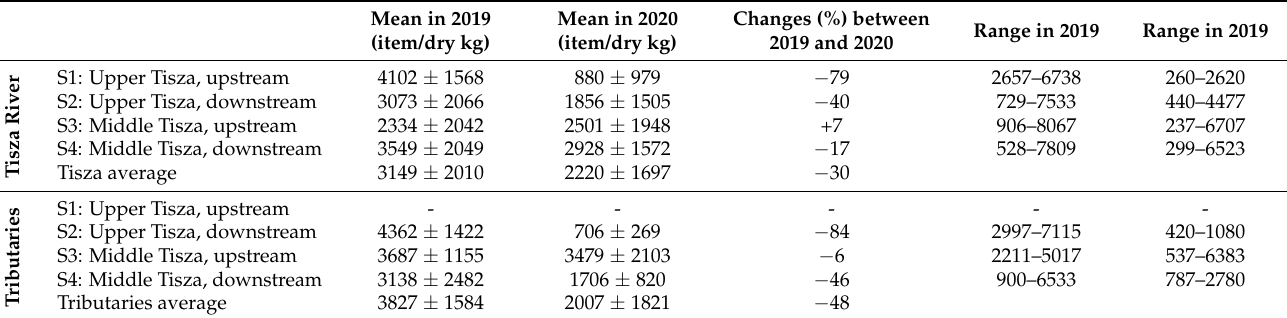
Table 2. Microplastic content (item/dry kg) of coarse sediments collected along the Tisza and its tributaries in 2019 [29] and